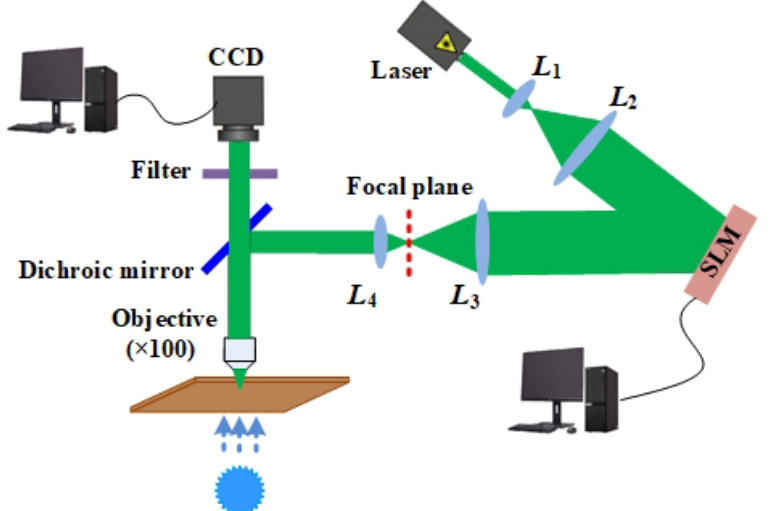
Figure 5. Schematic of the experimental setup.